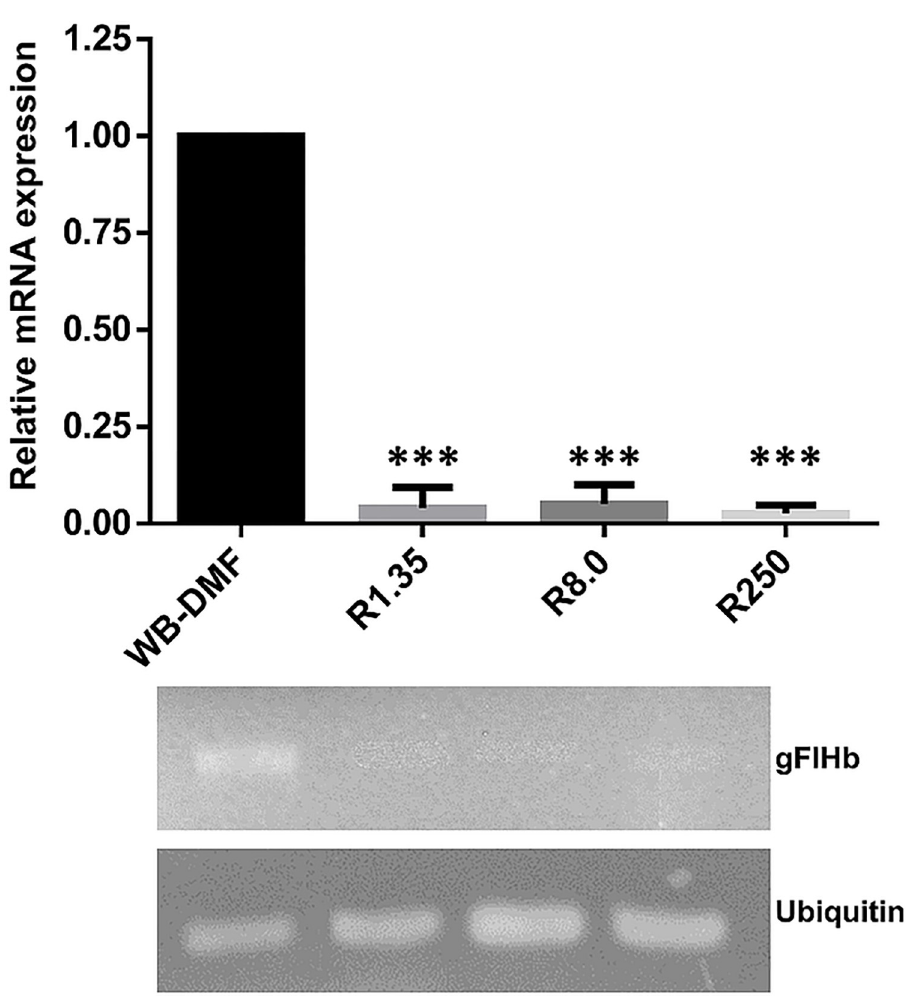
Fig 10. mRNA expression analysis of gFlHb of ABZ-resistant and ABZ–susceptible G . duodenalis trophozoites. The values represent the ratio of the optical densities of the PCR bands of gFlHb and internal standard ubiquitin. Densitometry values are the mean corresponding to n = 3 independent experiments. Asterisks denote a statistically significant difference ( � p < 0.05, �� p < 0.01 and p < 0.001), as determined by ANOVA test.